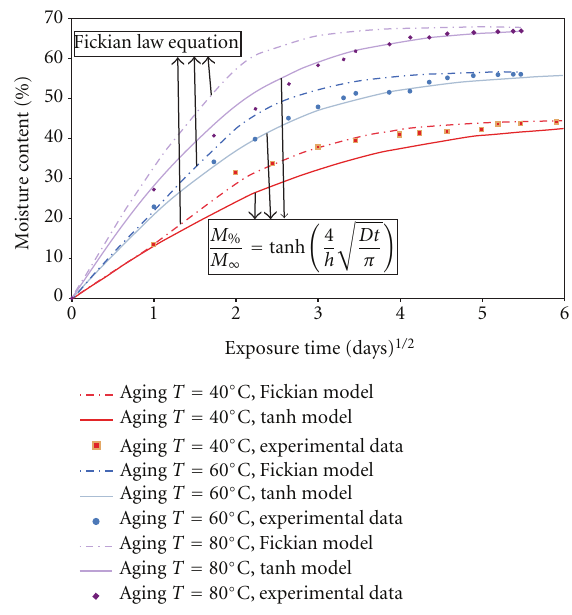
Figure 3: Moisture absorption of the specimens aged at 40 ◦ C, 60 ◦ C, and 80 ◦ C temperature (humidity = 60%).